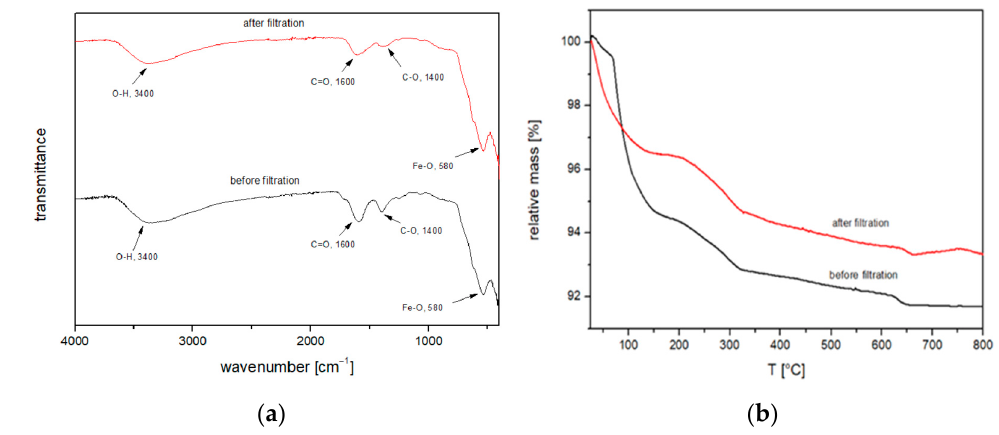
Figure 13. ( a ) FTIR spectrum of Fe 3 O 4 @CA MNPs before (red) and after (black) FO process and ( b ) TGA analysis curve of Fe 3 O 4 @CA after FO process.